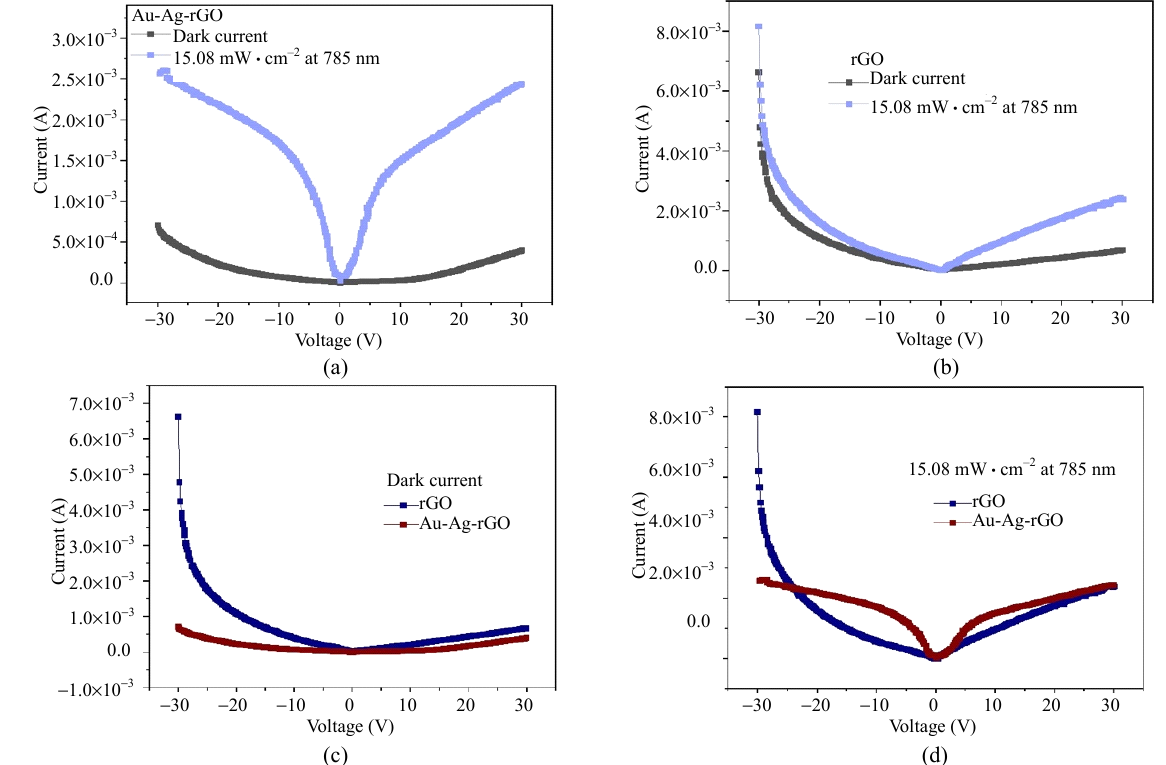
Fig. 4 Current-voltage ( I - V ) curves by device comparisons (a) – (b) as Au-Ag and rGO and by conditions (c) – (d) of the dark current and under the illumination of NIR LED 785 nm with 15.08 mW  cm –2 power intensity.